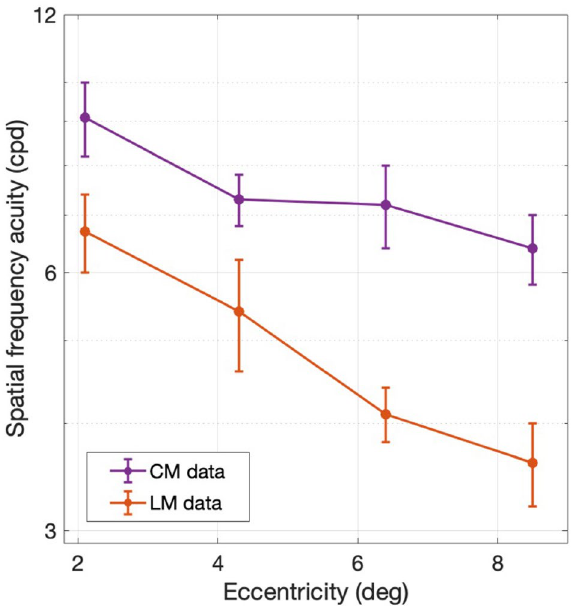
Figure 8. Spatial frequency acuity (i.e., SF corresponding to 75% correct) obtained by curve-fitting the high-SF fall-off of the individual subject data in Figs. 6 and 7 for LM (orange) and CM (purple) stimuli, respectively. Error bars indicate ± SEM (N = 6